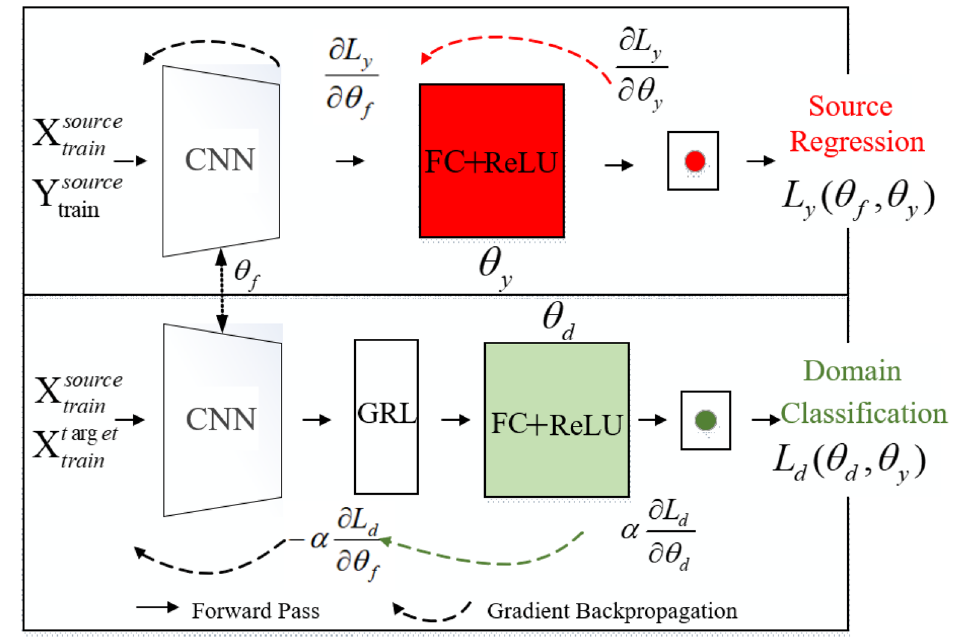
Figure 2. The architecture of